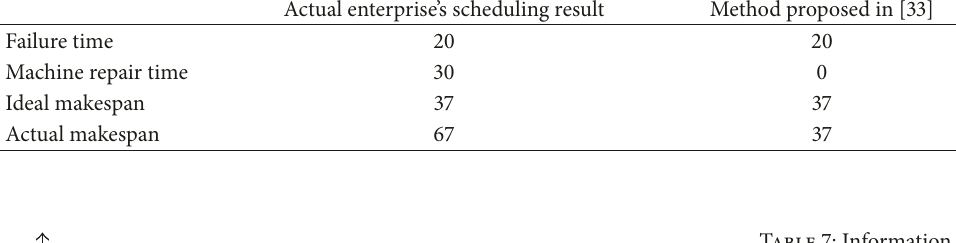
Table 7: Information for dynamic events.